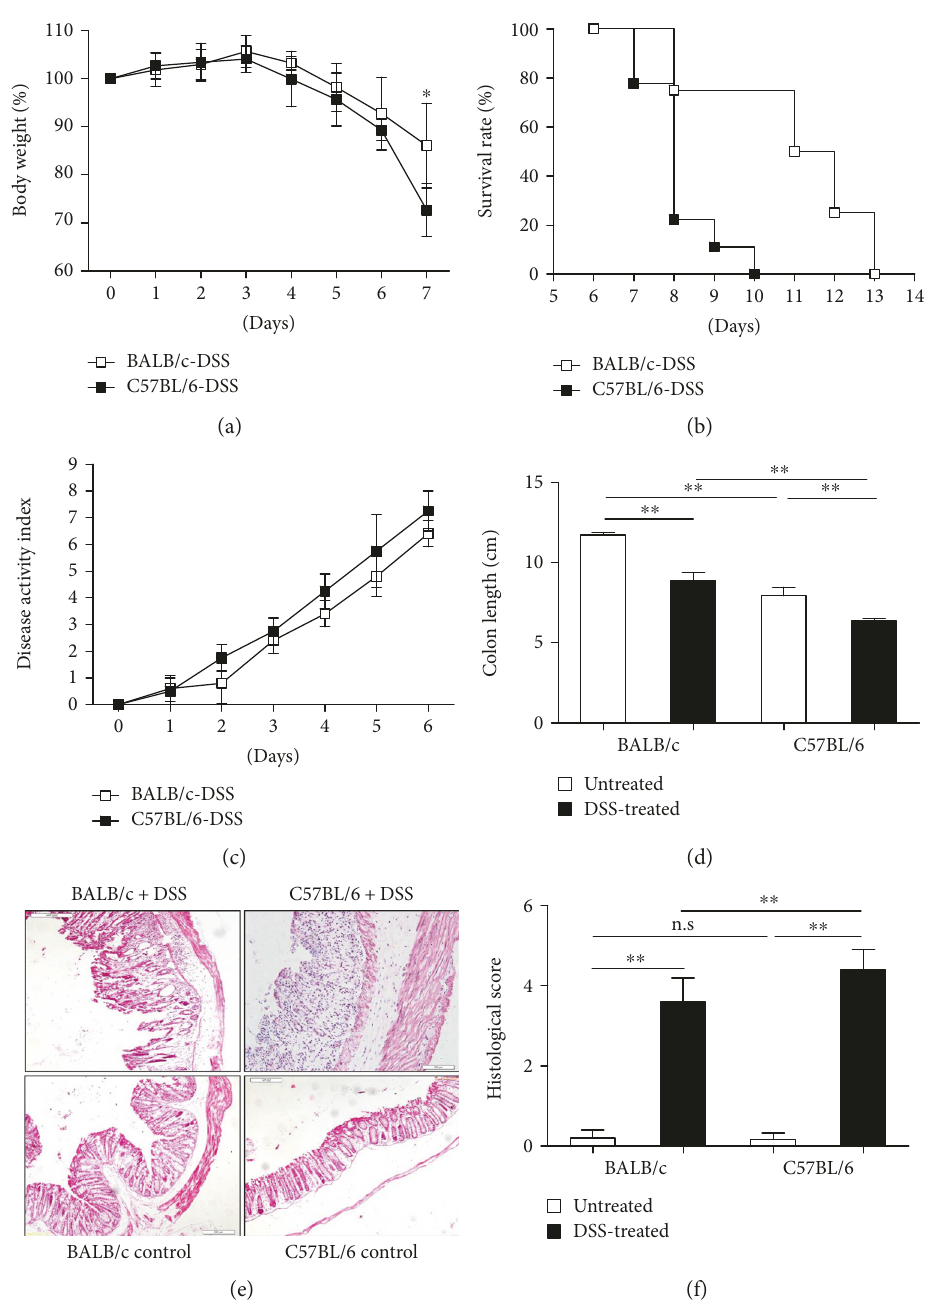
Figure 1: Compared to C57BL/6 mice, BALB/c mice are resistant to DSS-induced mucosal damage and development of acute colitis. Weight loss, survival rate, disease activity index (DAI), colon length, macroscopic changes, and H&E staining of the colon (original magni fi cation × 200) are shown. (a) Weight changes following DSS challenge in C57BL/6 and BALB/c mice. (b) Kaplan-Meier survival curves of BALB/c and C57BL/6 mice following exposure to 3.5% DSS in drinking water ( n = 10 ). (c) DAI and (d) colon length changes. (e) Macroscopic changes. (f) H&E staining of colon (original magni fi cation × 200). ∗ p < 0 05 ; ∗∗ p < 0 01